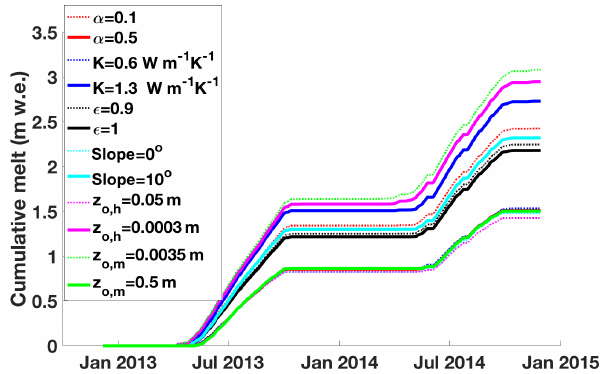
Figure 12. Cumulative glacier melt over the December 2012– November 2014 period under the extreme values for each param- eter listed in Table 4. An equivalent figure for each parameter may be found in Fig.